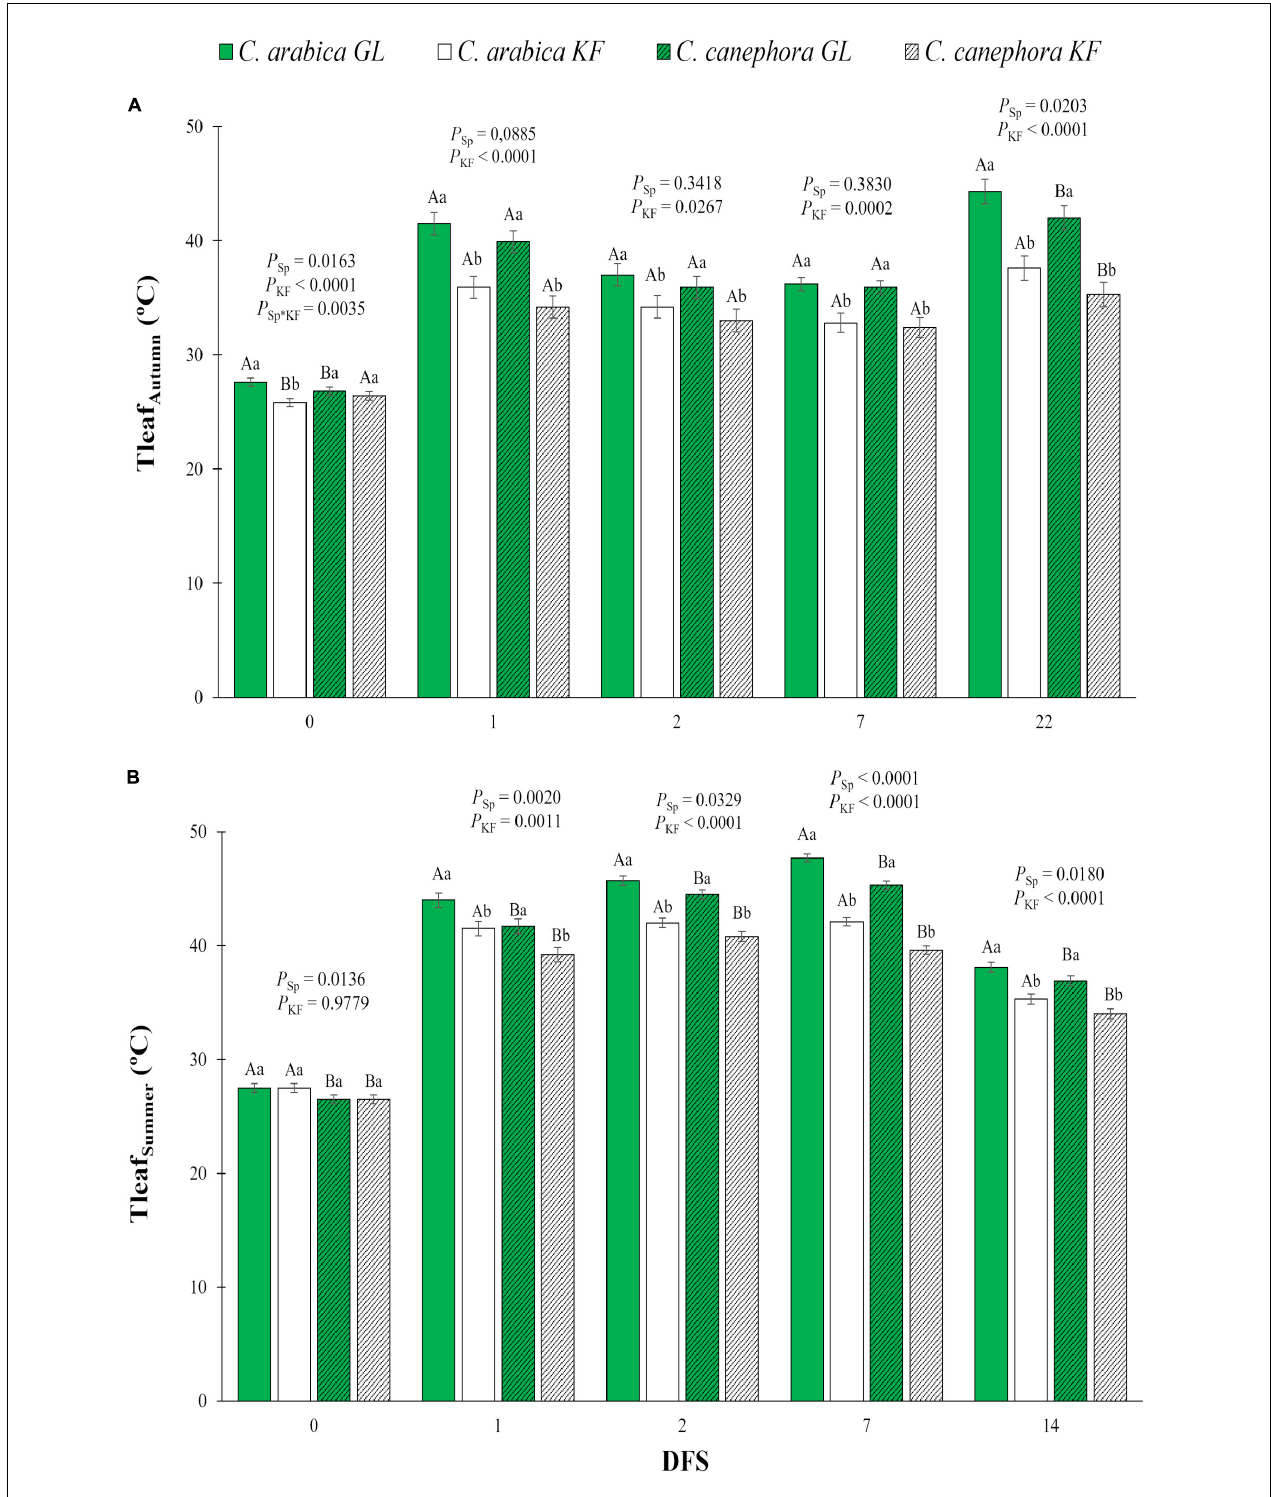
FIGURE 1 | Leaf temperature (T leaf ) estimated by thermography in young plants of two species (Sp), Coffea arabica and C. canephora , protected with kaolin film (KF) and not protected (GL), during the transference of coffee seedlings from nursery to full sunlight in (A) autumn (T leafAutumn ) and (B) summer (T leafSummer ). Means ± S.E. followed by different lowercase letters indicate statistically different values between kaolin treatments within the same species, while uppercase letters indicate differences between two coffee species within the same kaolin treatment, detected by the ANOVA and Tukey test ( n = 5). P -values for effects of species kaolin and their interactions are indicated for days of exposure to full sunlight